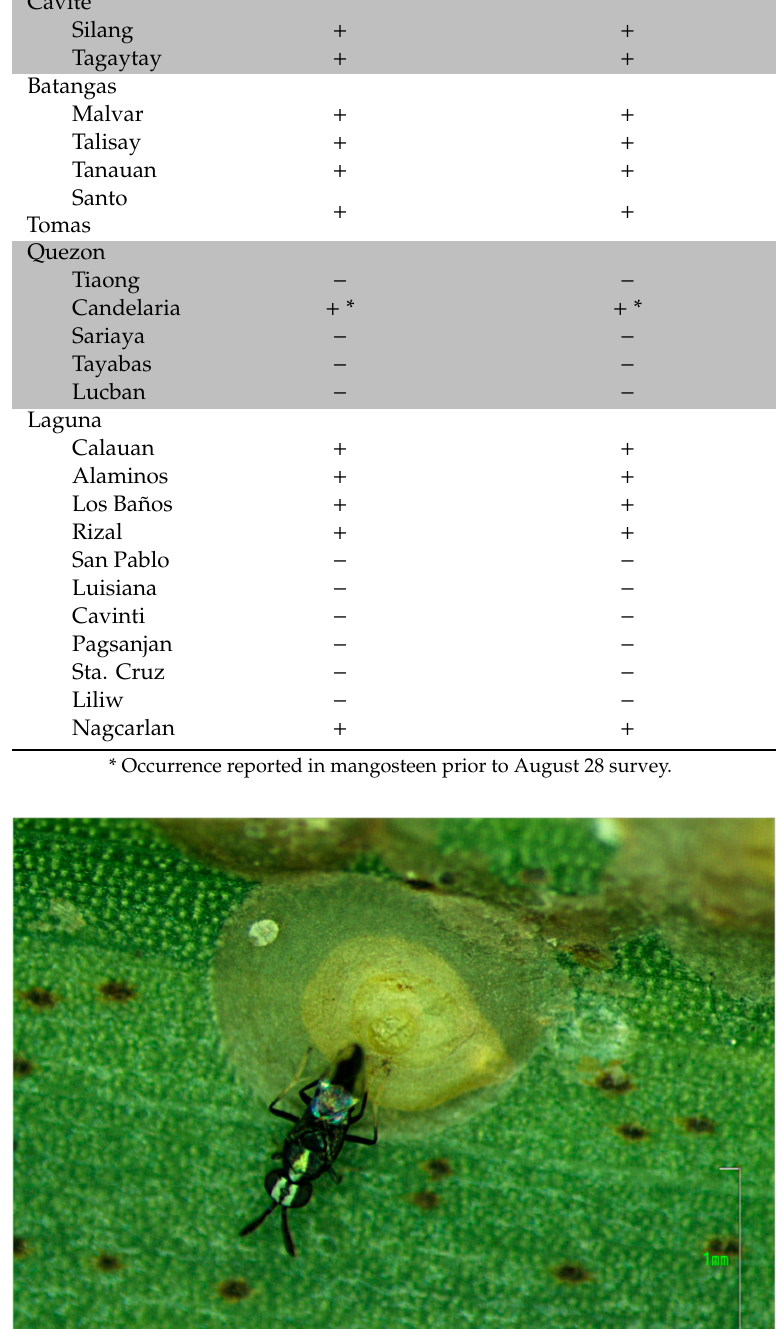
Table 2. Occurrence of Aspidiotus rigidus and Comperiella calauanica in select points in Southern Tagalog as observed across the three survey and sampling periods. Presence is indicated by + , while absence is indicated by − .